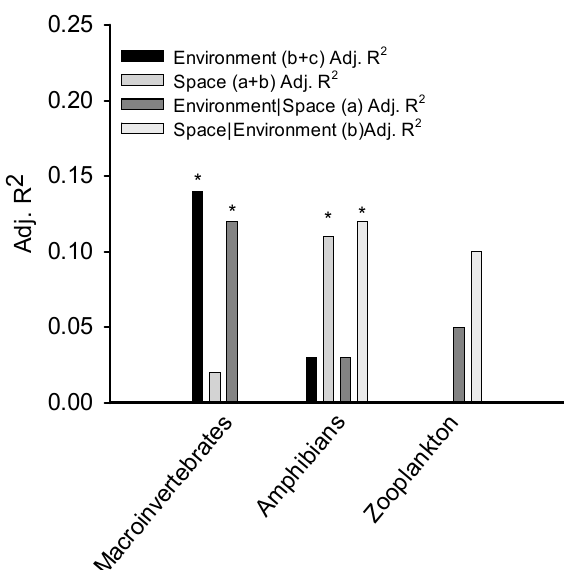
Figure 3. Bar plot showing the amount of community variation explained by spatial and local environmental variables. Local environment is variation explained by the local environment matrix with the spatial matrix as a covariate. Space is the variation explained by the spatial matrix with the local environment matrix as a covariate. Environment | Space is the variation explained by environment independent of the spatial matrix. Space | Environment is the variation explained by the spatial matrix independent of the environmental matrix. * denotes significance of each effect at α ~0.05.